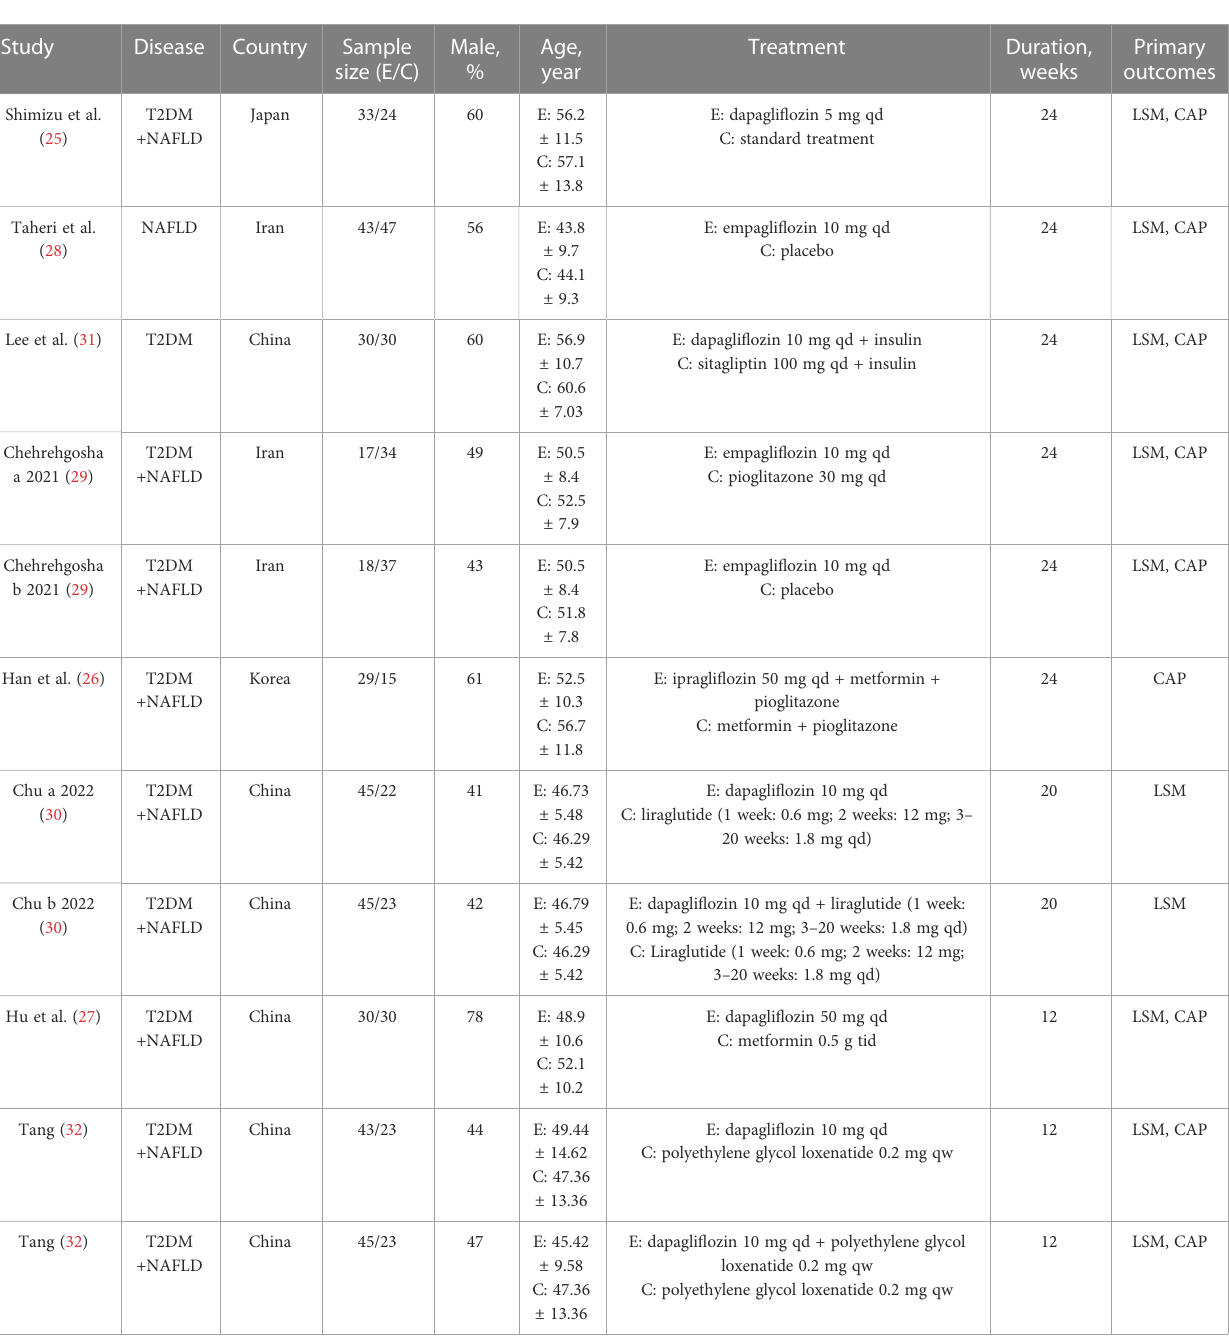
TABLE 1 Basic characteristics of the included